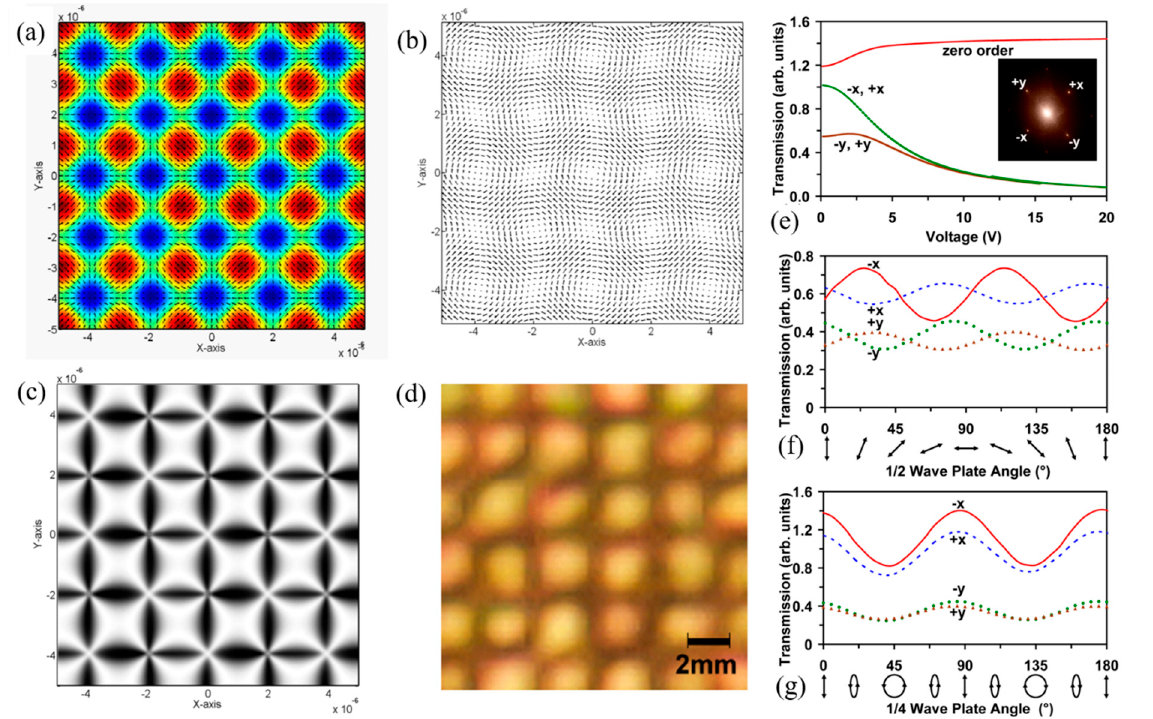
Figure 7. ( a ) Simulated intensity and polarization profile of the interference field of four p-polarized beams. ( b ) Simulated LC orientation and ( c ) LC texture between the crossed polarizers. ( d ) LC texture observed by POM. ( e ) Diffraction intensity as a function of the applied ac voltage. Inset: Diffraction pattern. The diffraction intensity of each order varies with ( f ) linear and ( g ) elliptical incident polarization. Reproduced with permission from Reference [44] © The Optical Society.